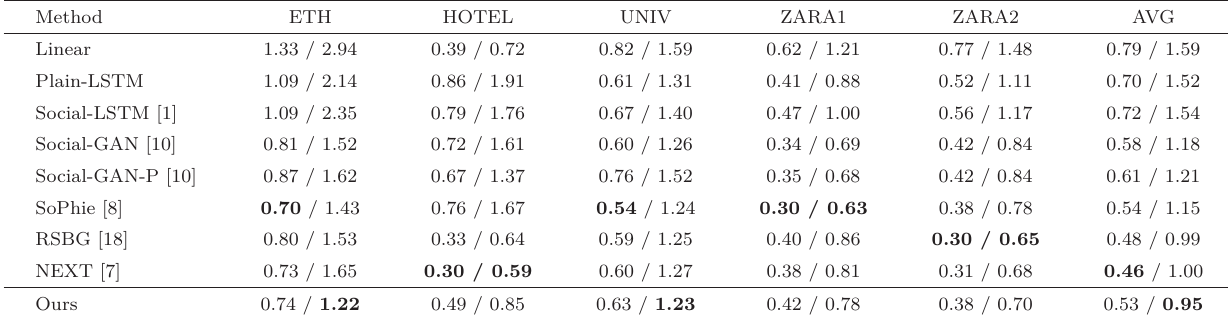
Table 1 Results using different methods on the ETH, HOTEL (from ETH), UNIV, ZARA1, and ZARA2 (from UCY) datasets. Error metrics used are ADE and FDE for the task of predicting 12 future time steps